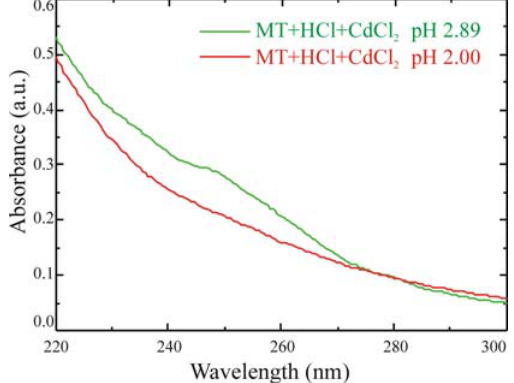
Figure 9. Absorbance spectra of a 100 mg/mL MT solution at different pH: 2.89 (green line) and 2.00 (red